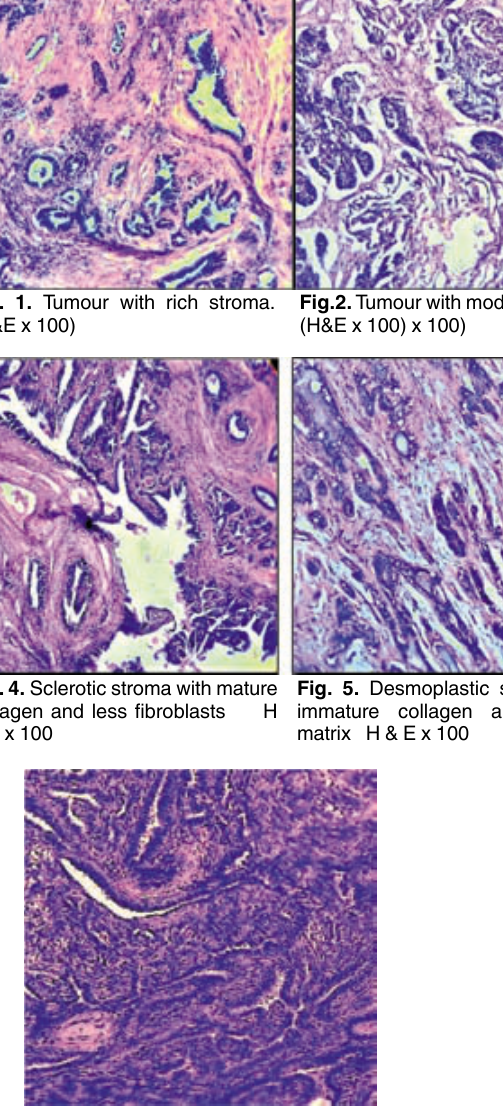
Fig.2. Tumour with moderate stroma. (H&E x 100) x 100)